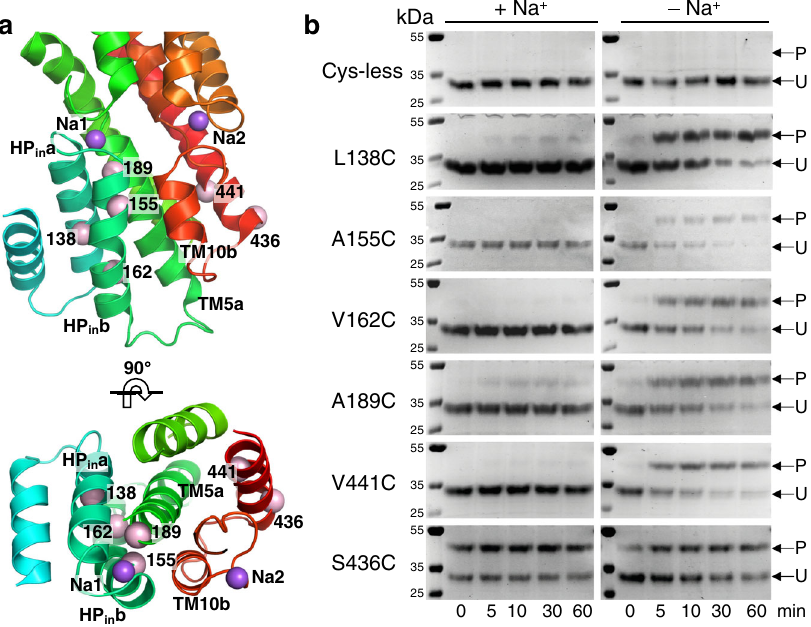
Fig. 4 Cysteine alkylation with mPEG5K of VcINDY near the Na1 and Na2 sites in the presence and absence of Na + . a Location of cysteine mutations. Our structures suggested that HP in b and TM10b become fl exible in the absence of sodium, increasing the solvent accessibility of Leu138, Ala155, Val162 and Ala189 near the Na1 site, and Val441 near the Na2 site. Position Ser436, for which no accessibility change was observed between our structures, is used as a control. On a Cys-less background, residues at these positions were individually mutated to a cysteine for mPEG5K labeling. For clarity, only amino acid numbers are labeled and the types are omitted. b Coomassie Brilliant Blue-stained non-reducing polyacrylamide gels showing the site-directed PEGylation of each cysteine mutant over time in the presence and absence of Na + . P: PEGylated protein; U: Un-PEGylated protein. Each reaction was performed on two separate occasions with the same result. Source data is provided as Source Data fi le.